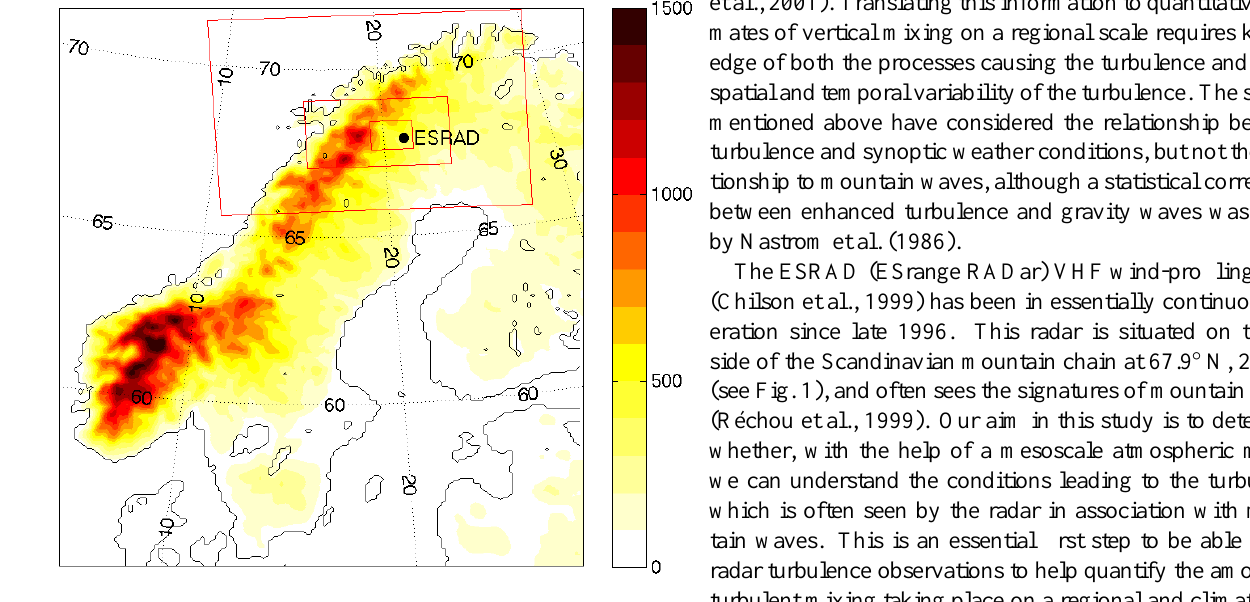
Fig. 1. Map of Scandinavia showing the topography (colour scale with heights in m), the location of the ESRAD radar, and the nested model domains used for the WRF simulations (red rectangles). The outermost domain has horizontal resolution 15km, the indermediate domain 3km, and the inner domain around the location of ESRAD has 1km resolution. Lines of latitude and longitude are shown with dotted